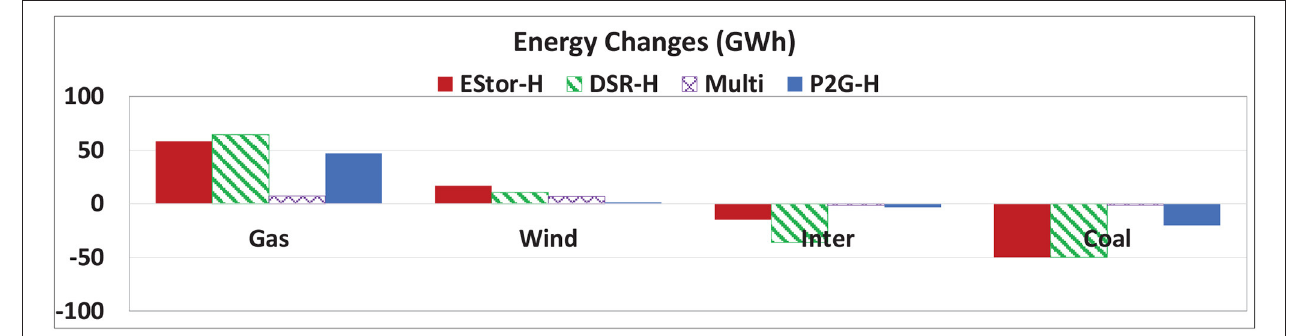
FIGURE 9 | Change in the electricity in presence of different flexibility options during the day of gas supply interruption compared to the Ref